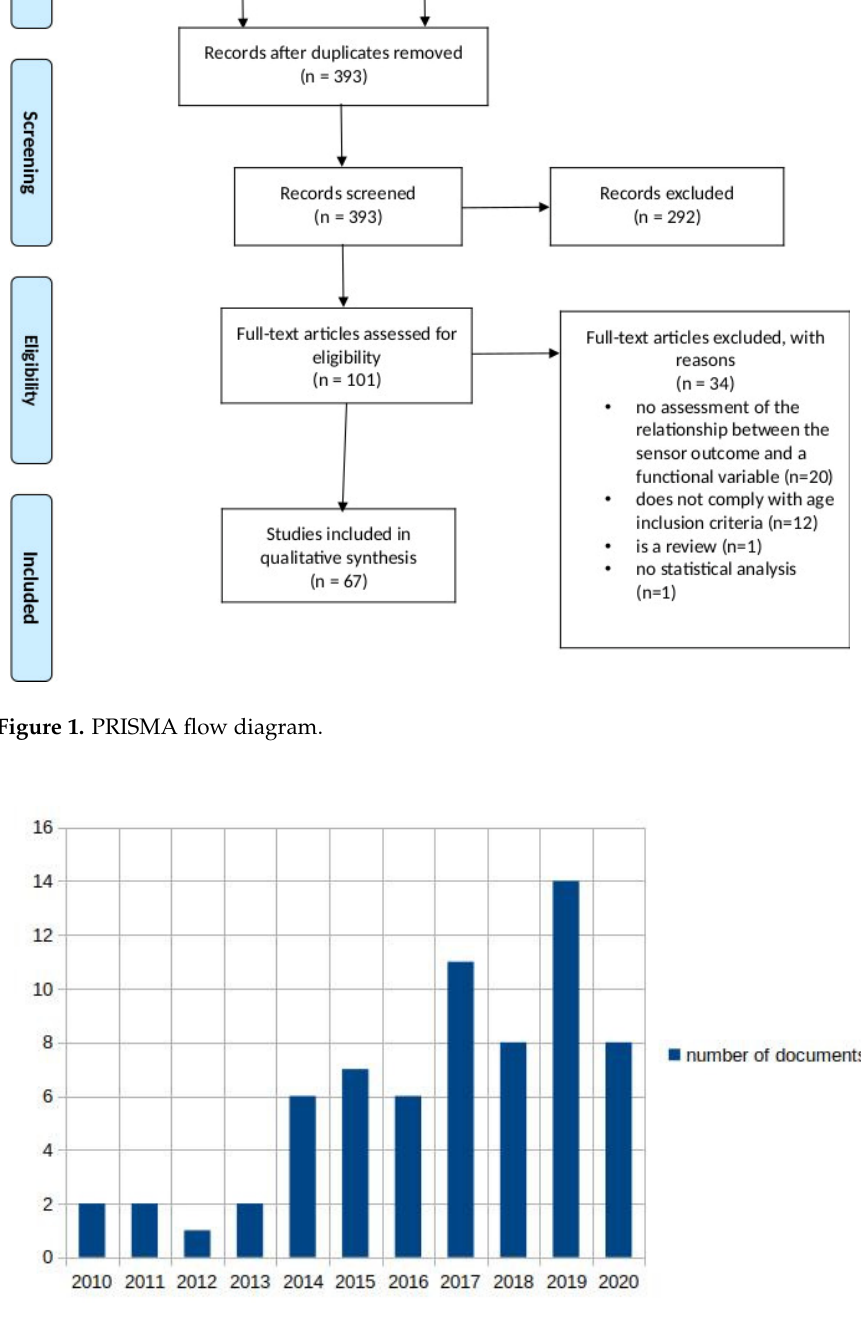
Figure 2. Number of documents over time.